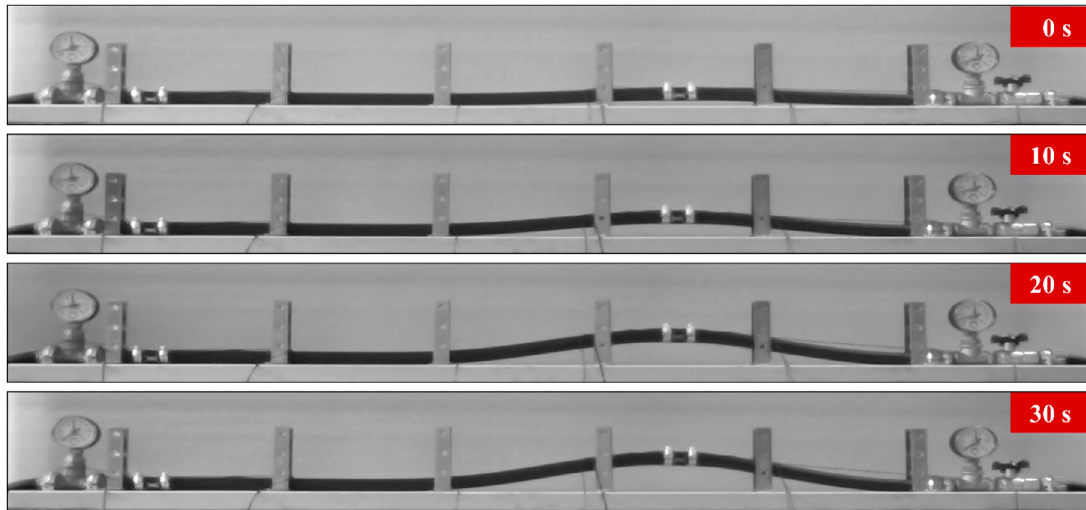
Figure 4. Selected frames from the video of the experiment (lasting 30 s): as the temperature was raised from 23.8 (room temperature) to 35.4 °C, buckling took place; a pre-existing bend in the tube was exploited to “catalyze” the process.